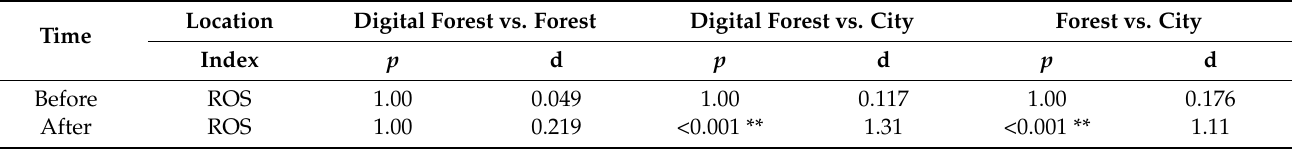
Table 12. Analysis results of ROS in three settings (multiple comparisons). Digital Forest vs. City